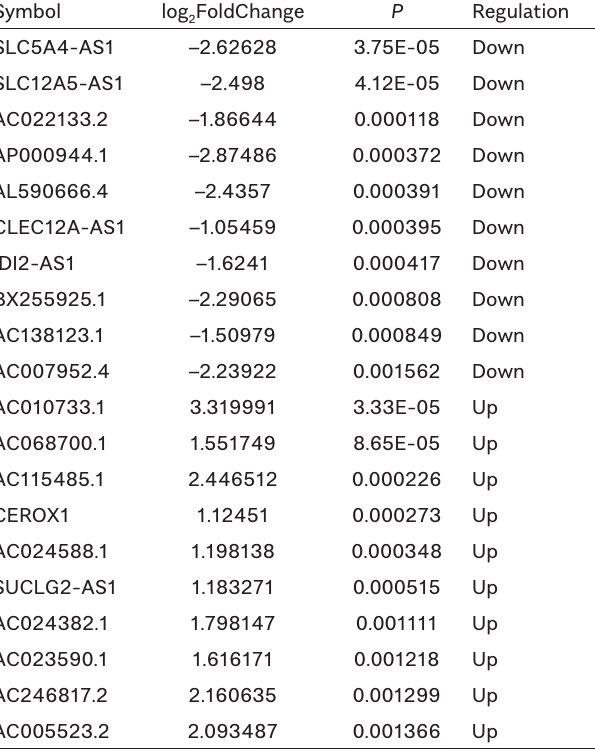
Table 1. Top 10 Up- and down Regulated DEmRNAs in reHCC Symbol